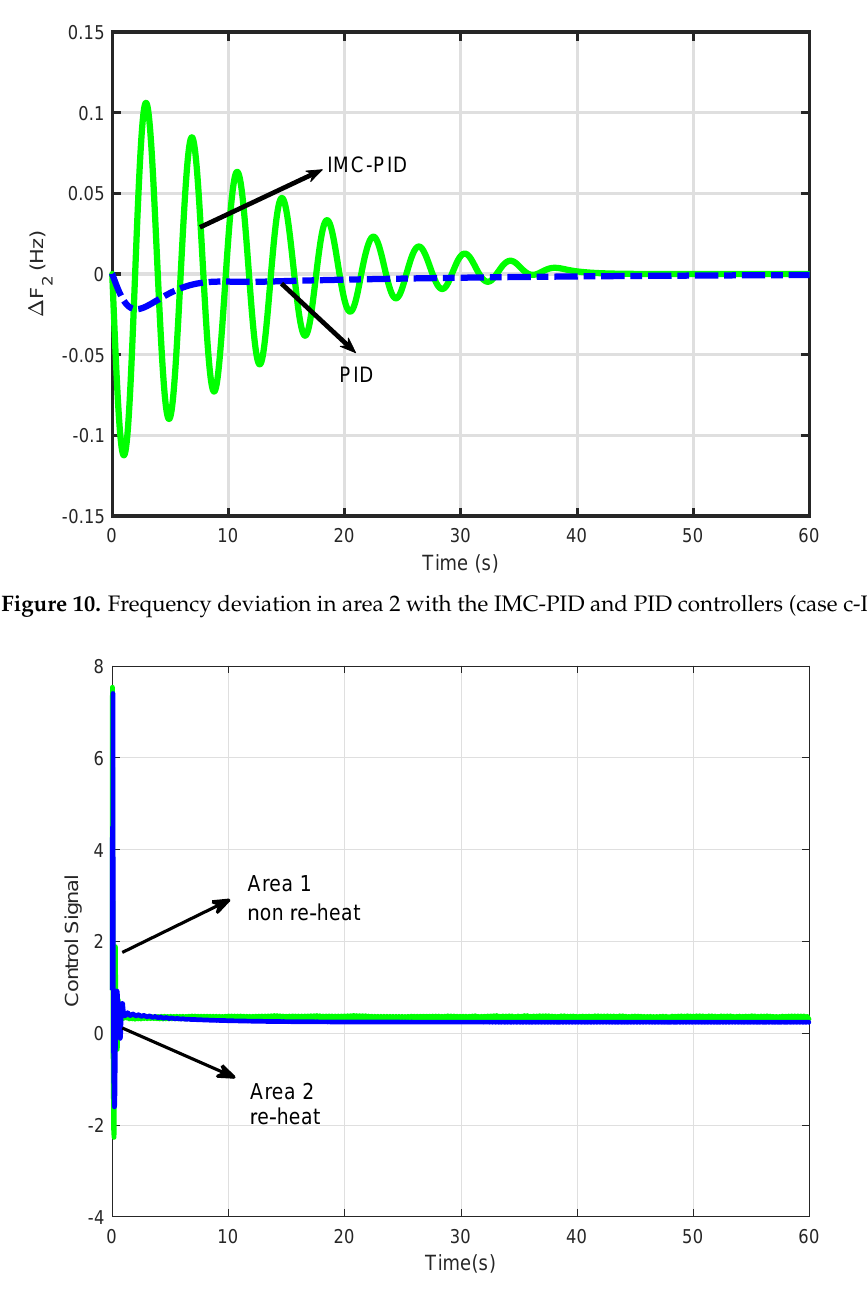
Figure 11. Control signal in areas 1 and 2 with our proposed